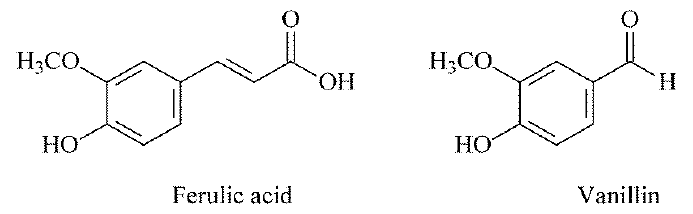
Figure 1. Structures of ferulic acid and vanillin.